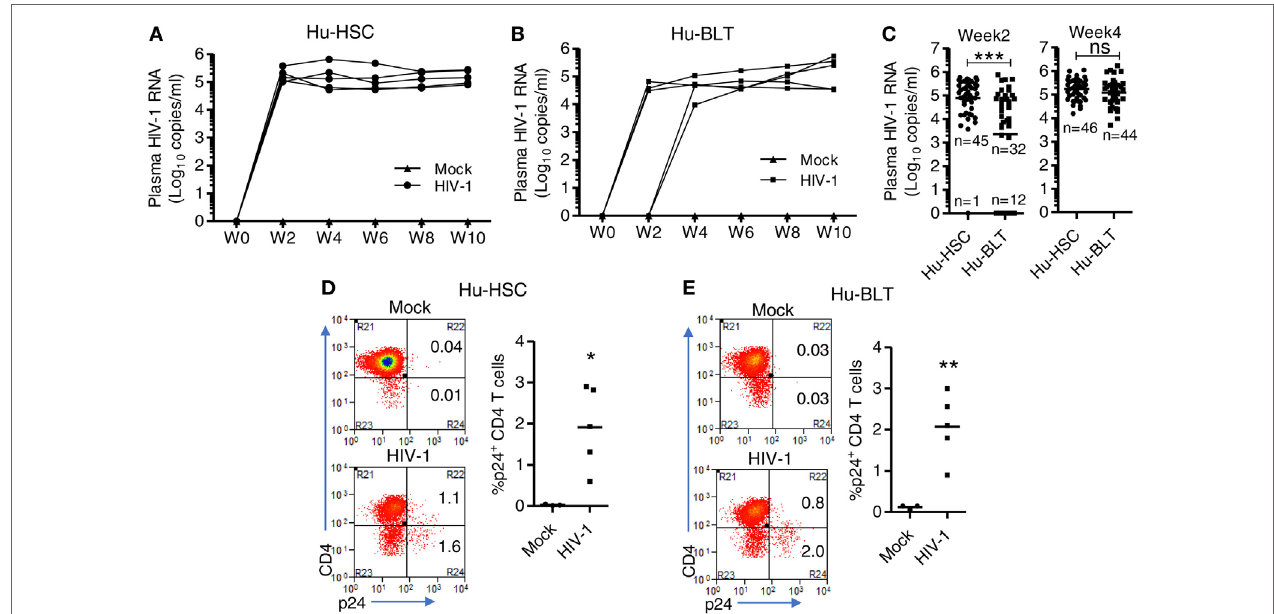
FigUre 5 | HIV-1 replication kinetics in NRG-hu HSC and NRG-hu Thy/HSC mice in vivo . NRG-hu HSC and NRG-hu Thy/HSC mice were infected with HIV-1 at 12–13 weeks postinfection (wpi). (a,B) Plasma HIV-1 genomic RNA levels were measured at indicated time points in each NRG-hu HSC (a) and NRG-hu Thy/HSC (B) mice. Shown are representative data from n = 3 (NRG-hu HSC/Mock), n = 5 (NRG-hu HSC/HIV-1), n = 3 (NRG-hu Thy/HSC/Mock), and n = 5 (NRG-hu Thy/ HSC/HIV-1) mice transplanted with HSCs ± thymus from the same donor. The broken horizontal line indicates the limit of detection (400 copies/ml). (c) Summary data show plasma HIV-1 genomic RNA levels at 2 and 4 wpi from NRG-hu HSC ( n = 46) and NRG-hu Thy/HSC ( n = 44) mice. Shown (c) are combined data from five cohorts of NRG-hu HSC mice and six cohorts of NRG-hu Thy/HSC mice. The viral infection data were collected previously by the laboratory. (D,e) Representative FACS plots and summarized data show percentages of HIV-1 p24-positive CD4 T cells (CD3 + CD8 − ) in the spleen of NRG-hu HSC (D) and NRG-hu Thy/HSC (e) mice at 10 wpi. Shown are representative data from n = 3 (NRG-hu HSC/Mock), n = 5 (NRG-hu HSC/HIV-1), n = 3 (NRG-hu Thy/HSC/Mock), and n = 5 (NRG-hu Thy/HSC/HIV-1) mice transplanted with HSCs ± thymus from the same donor. Each dot represents one individual mouse; bars indicate mean (* P < 0.05, ** P < 0.01, and *** P < 0.001, by unpaired, two-tailed Student’s t